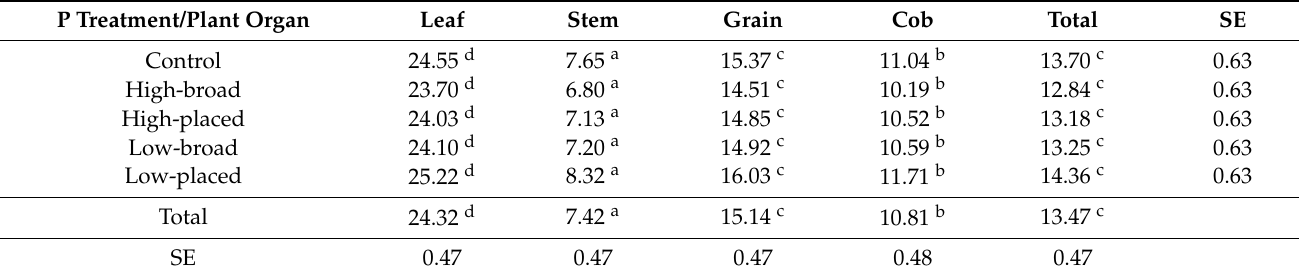
Table 4. Means of Zn concentration (mg kg − 1 DW) and standard error (SE) at the ripening stage as a function of P treatments and maize parts ( n = 160), different letters indicate significant differences at the p < 0.05 level (Tukey’s test). P Treatment/Plant